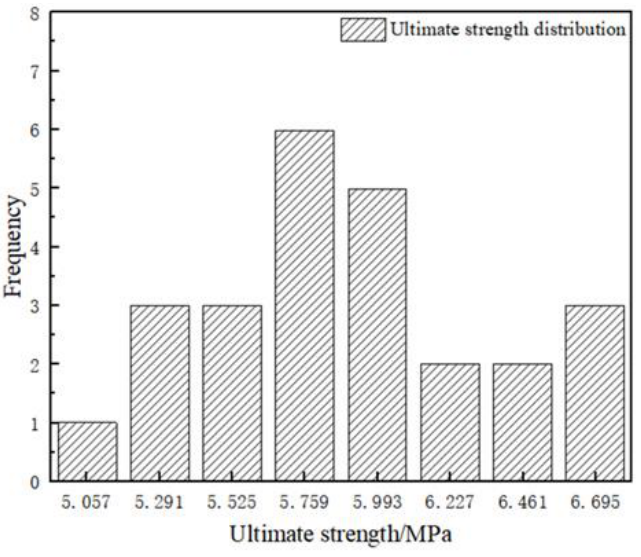
Figure 8. Ultimate strength histogram.